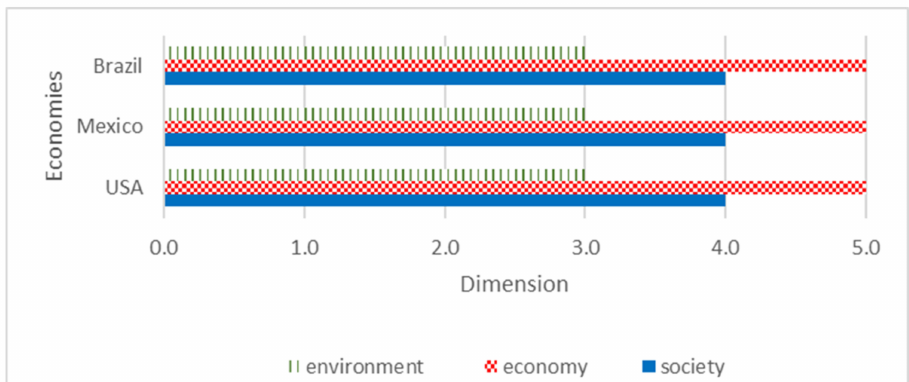
Figure 3. Sub-dimensional energy resilience of American economies.